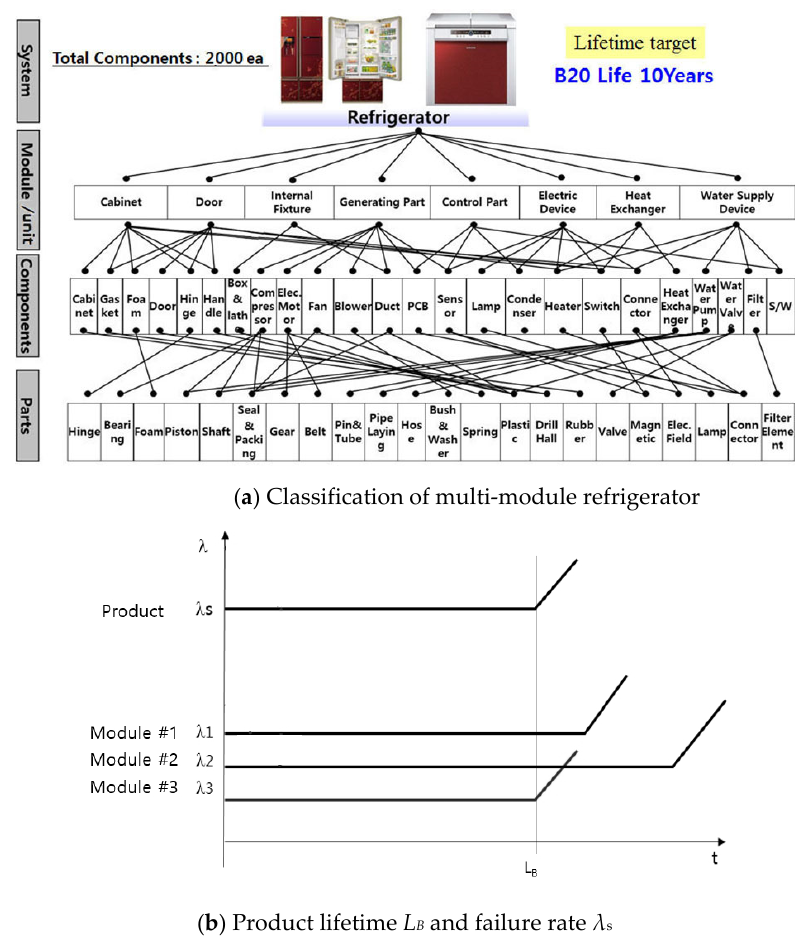
Figure 1. Product lifetime with multi-modules decided by newly designed module ( a ) Classification of multi-module refrigerator; ( b ) Product lifetime L B and failure rate λ s